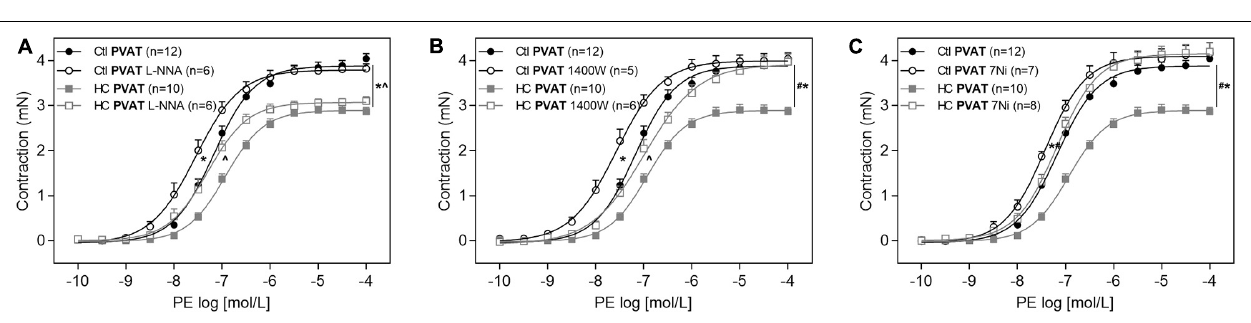
FIGURE 7 | Involvement of PI3k-Akt-NOS pathway in the effect of HC diet on PVAT control of vascular tone and evaluation of NO availability. Cumulative concentration-response curves for PE in the presence of PVAT in aortas of control and HC groups previously incubated or not with (A) LY294,002 or (B) L-NAME. Values represent mean ± SEM. The total number of animals required to carry out the experiments in each group ( n ) is presented in parentheses. Statistical significance was determined using two-way ANOVA followed by Holm–Sidak’s post hoc test. * p < 0.05 vs. control PVAT; # p < 0.05 vs. HC PVAT represent the differences in the Emax and pD 2 values. Representative sections of basal NO availability in the PVAT of (C) control and (D) HC groups exposed to DAF-2DA probe. Arrows indicate the location of the endothelial layer of blood vessels. Scale bars indicate 100 µ m. (E) Quantification of NO production in the PVAT was expressed as fluorescence intensity in graphical bars with mean ± SEM. The total number of animals required to carry out the experiments in each group ( n ) is presented in the dispersion points in the graphs. Statistical significance was determined using Student’s t -test. * p < 0.05 vs. control.